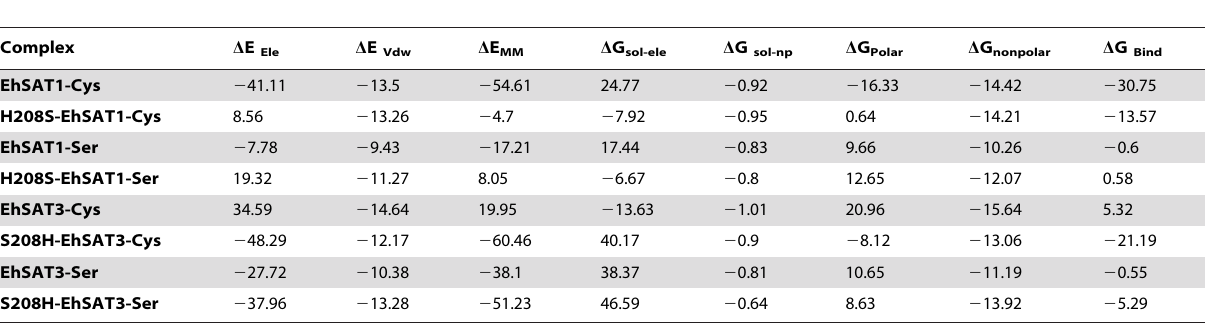
Table 1. The binding free energy of EhSAT1 and EhSAT3 complexes.